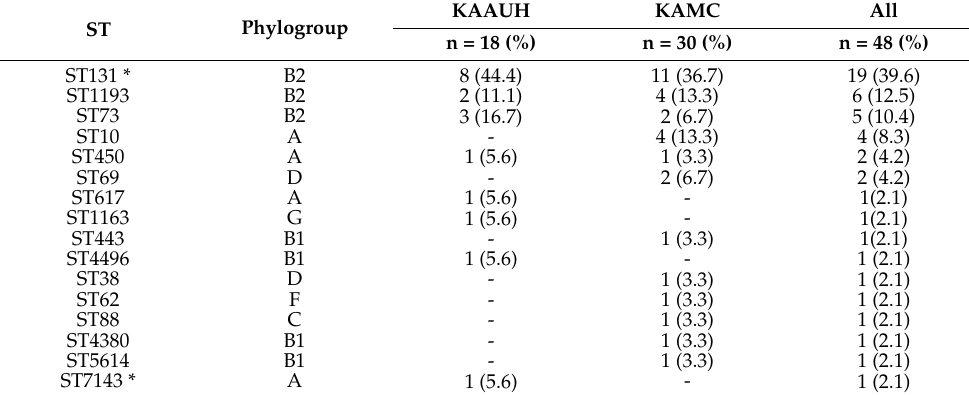
Table 2. Prevalence of ESBL STs in KAAUH and